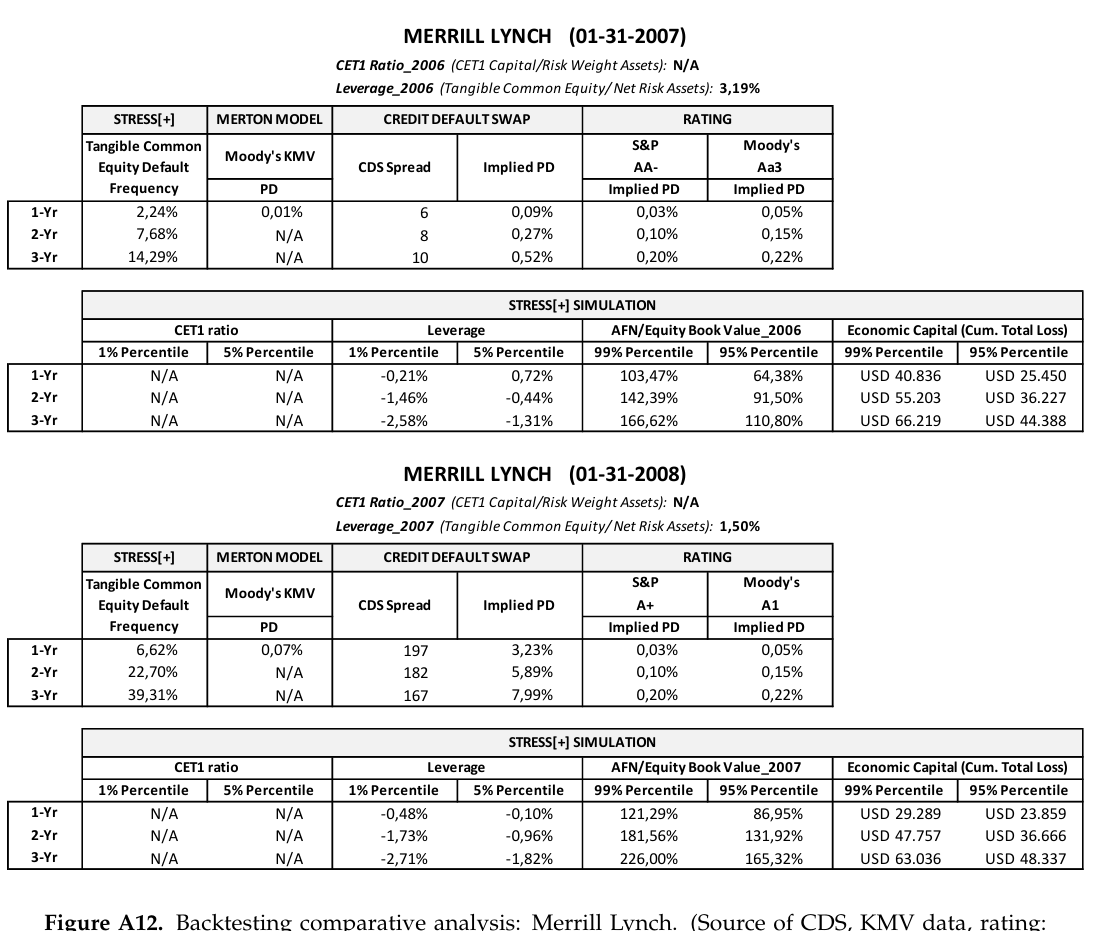
Figure A13. Backtesting comparative analysis: Northern Rock. (Source of CDS, KMV data, rating: Bloomberg, Moody’s KMV, Standard & Poor’s ).